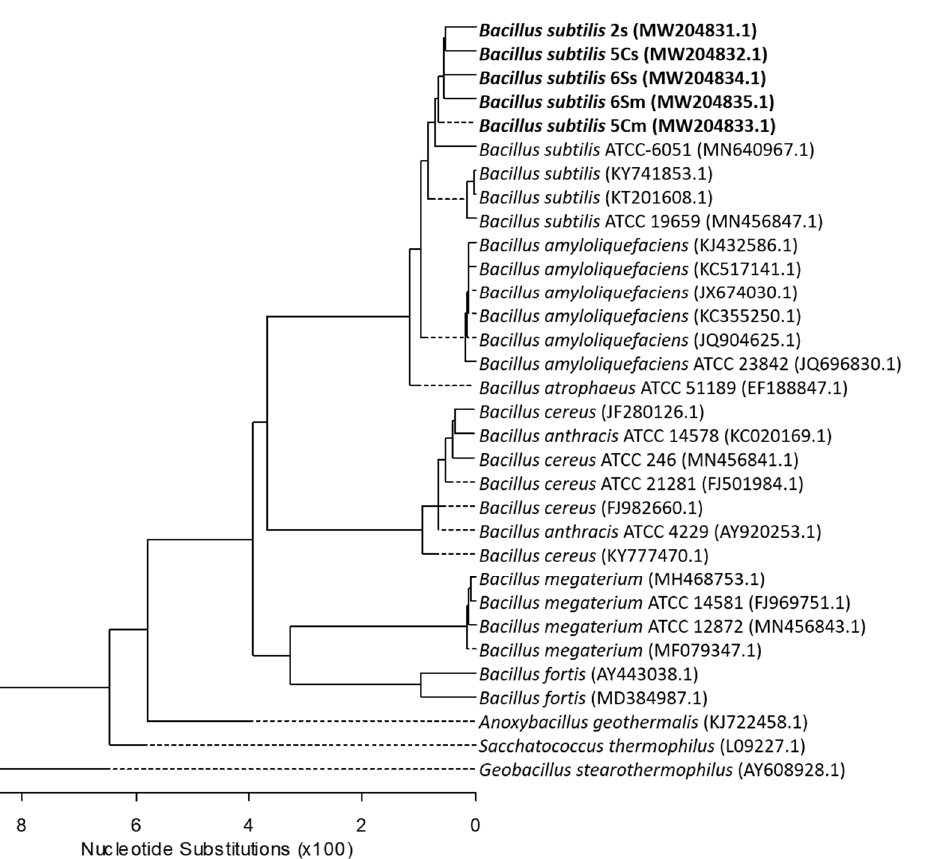
Table 3. Cell morphology and biochemical characteristics of carbon metabolisms and enzymatic activity of the five selected bacteria. Title